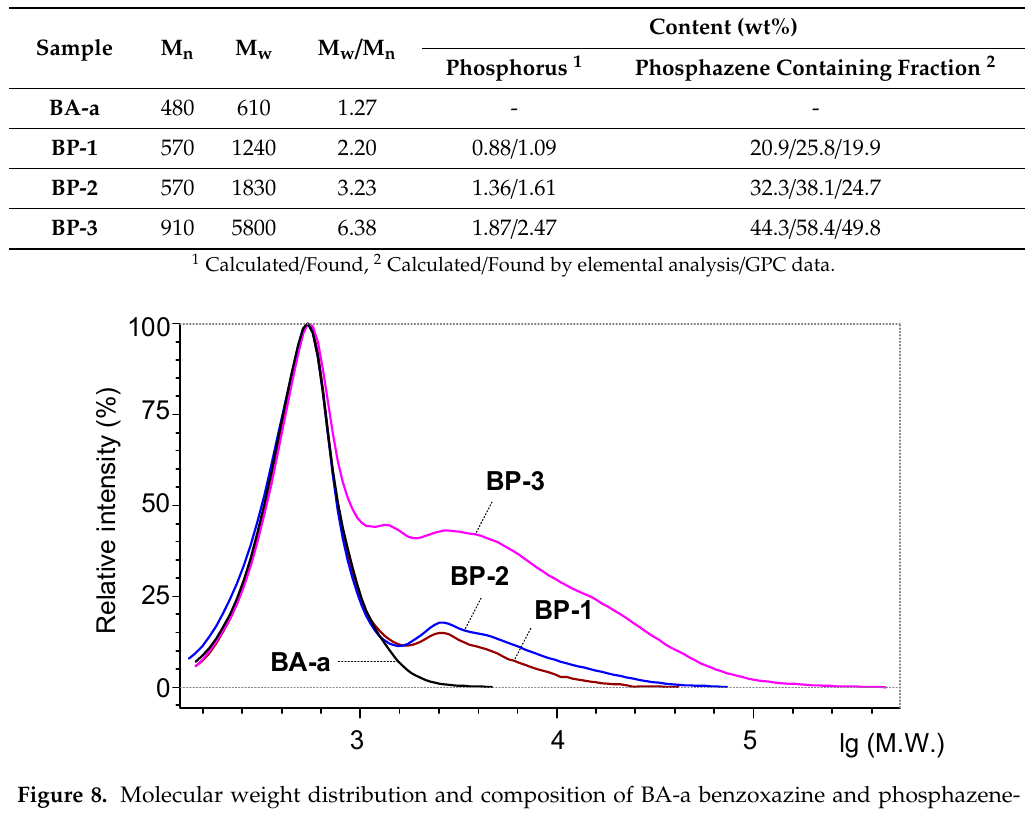
Table 3. Molecular weight characteristics and composition of phosphazene-containing benzoxazines.